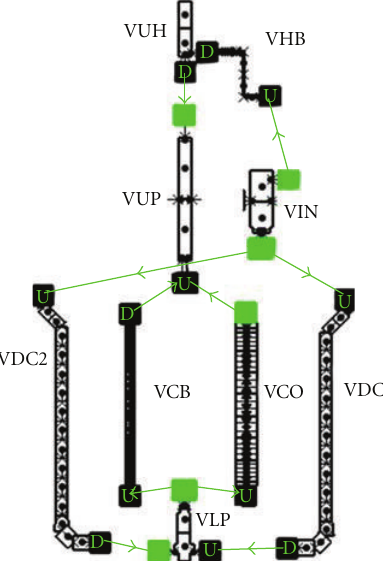
Figure 2: CATHARE modelling of the PKL reactor vessel compo-